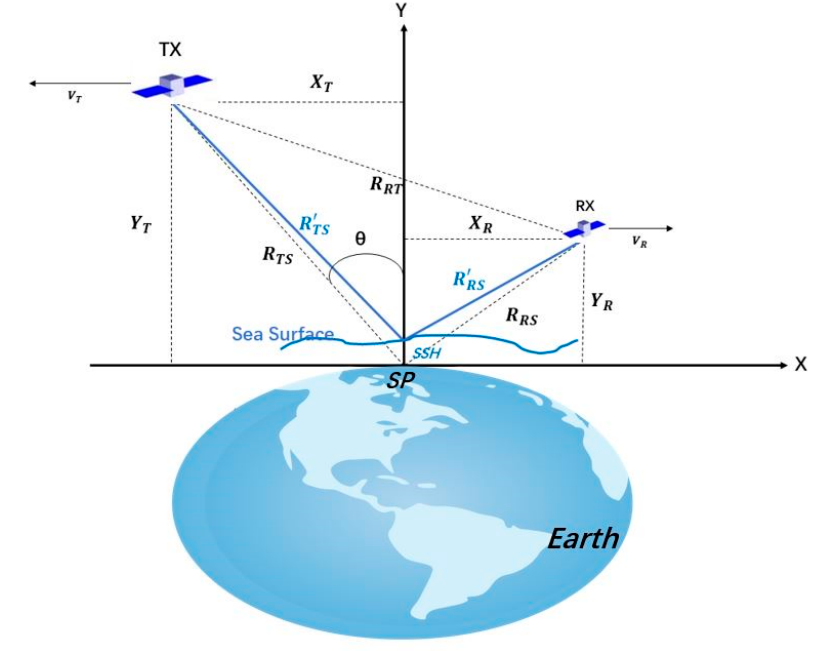
Figure 2. Reflectometry altimetry geometry.